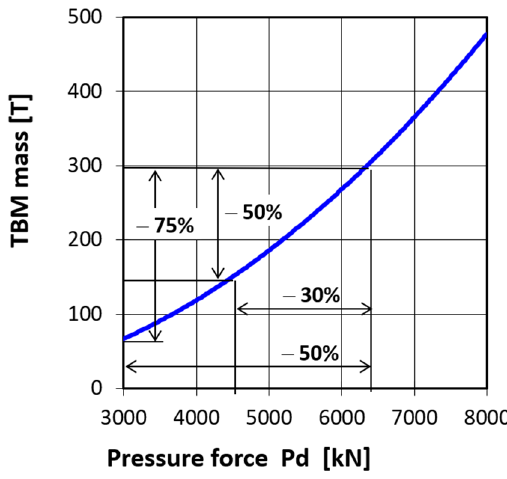
Figure 2. Influence of the TBM’s pressure force on its mass [6].